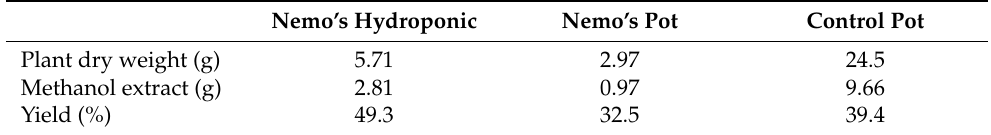
Table 5. Yields of the extraction process of the three analyzed samples of Stevia rebaudiana